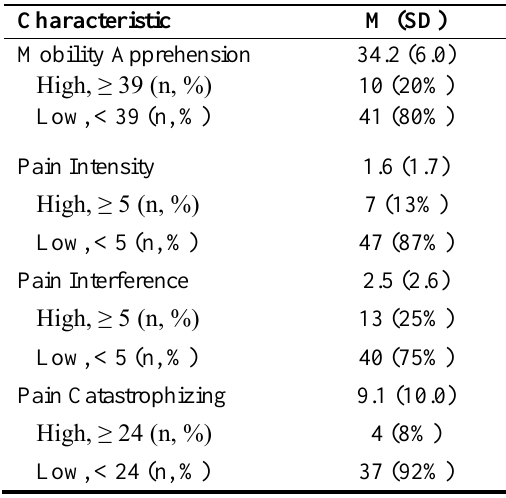
Table 2. Self-report instrument data Characteristic M (SD) Mobility Apprehension High, ≥ 39 (n, %)